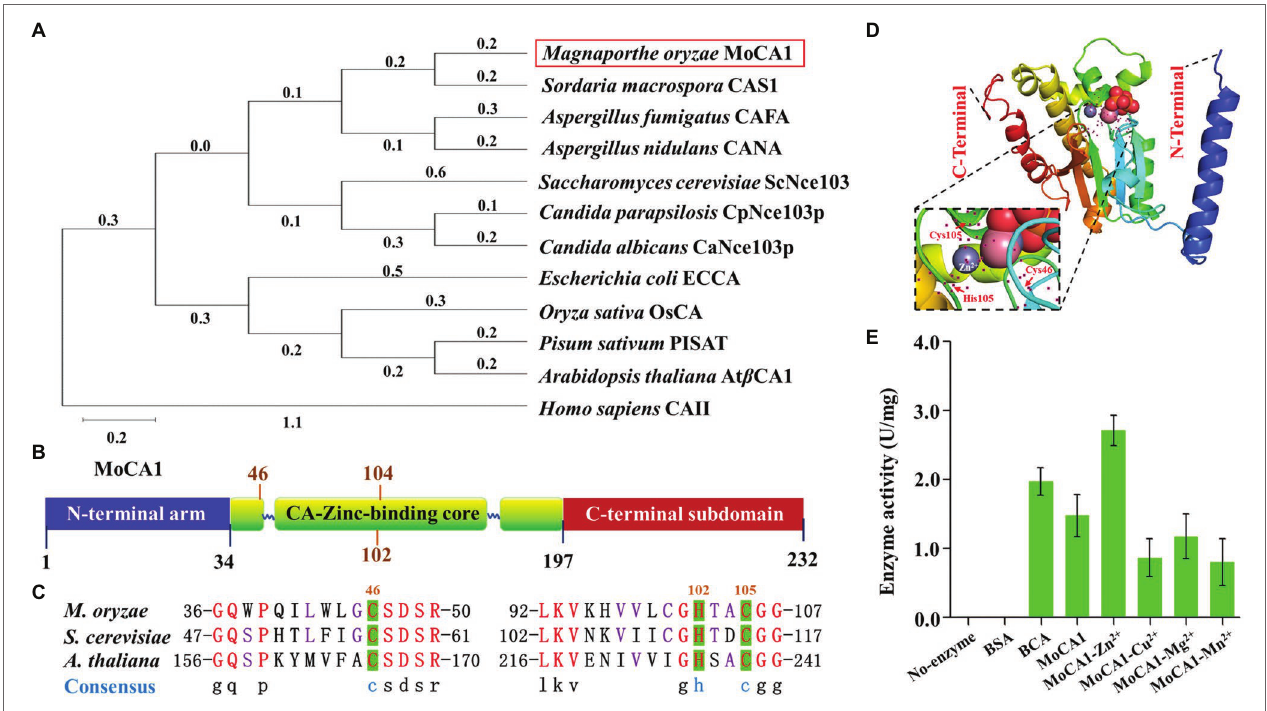
FIGURE 1 | Structure of the MoCA1, phylogenetic analysis, and identification of MoCA1. (A) Phylogenetic tree constructed with β -CA proteins homologs from Magnaporthe oryzae , Sordaria macrospora , Aspergillus fumigatus , Aspergillus nidulans , Candida parapsilosis , Candida albicans , Saccharomyces cerevisiae , Escherichia coli , Pisum sativum , Arabidopsis thaliana , and Homo sapiens . (B) Structure of the MoCA1. MoCA1 is a Zn metalloenzyme. (C) Sequence alignment. A Zn ion coordinated by the three highly conserved residues two Cys and one His in M. oryzae , S. cerevisiae , and A. thaliana . (D) Tertiary structure (3-D) of MoCA1. (E) Measurement of MoCA1 activity. Tris buffer was used as a blank, BSA was used as a negative control, BCA was used as a positive control, and each ion with MoCA1 was compared with each